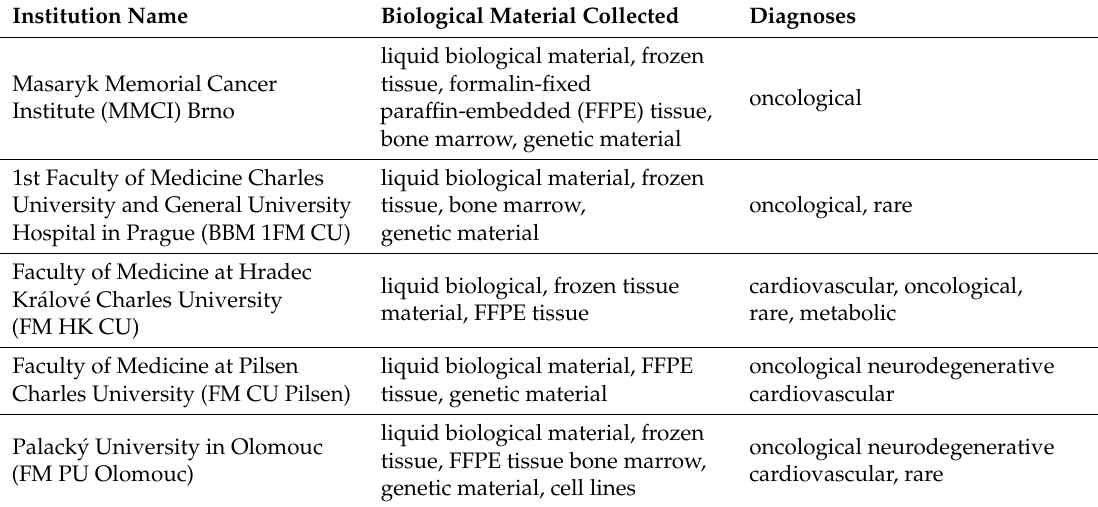
Table 1. Biological material collected in